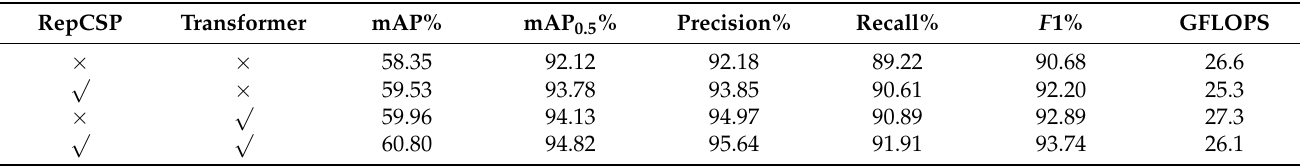
Table 1. Results of the ablation experiments.